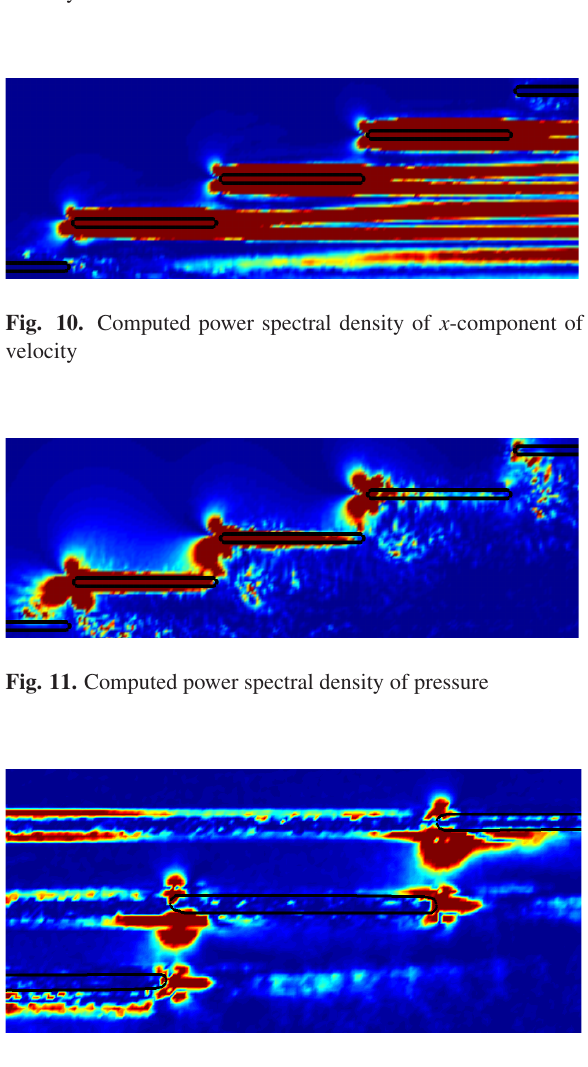
Fig. 9. Computed power spectral density of y -component of velocity Fig. 3. Computational domain and triangular mesh.